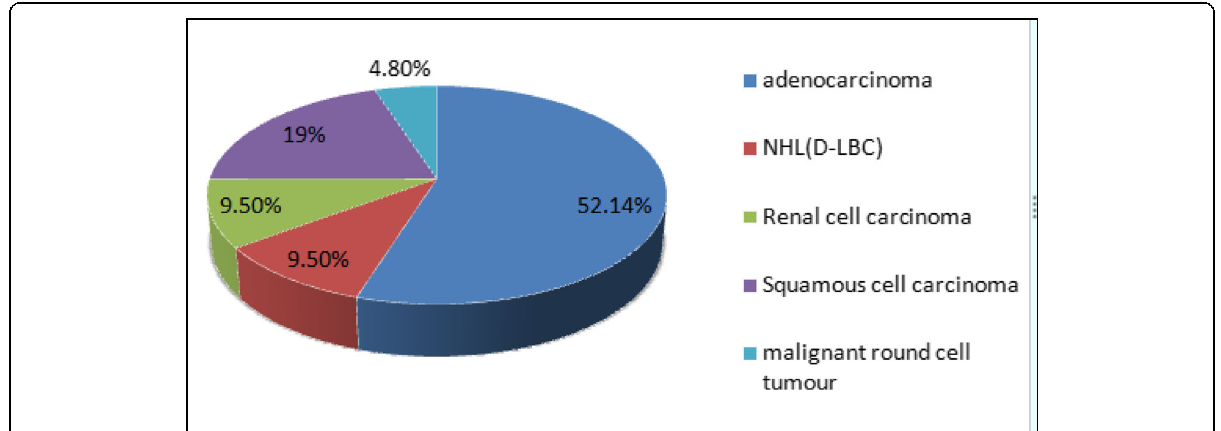
Fig. 1 The pathology of the primary tumor